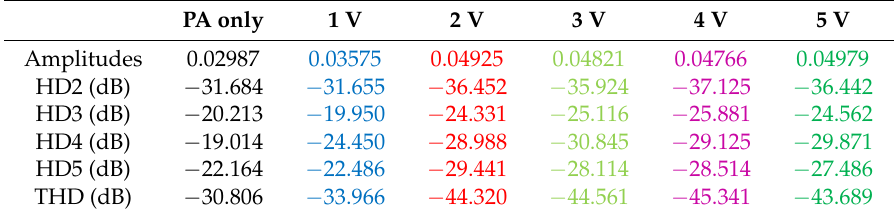
Table 1. Summary of the measured echo signal amplitudes, harmonic distortion (HD2, HD3, HD4, HD5), and total harmonic distortion (THD) of the 100 MHz piezoelectric transducers when using the PA without and with shunt-diode pre-linearizer when 1, 2, 3, 4, and 5 V DC voltages were applied.